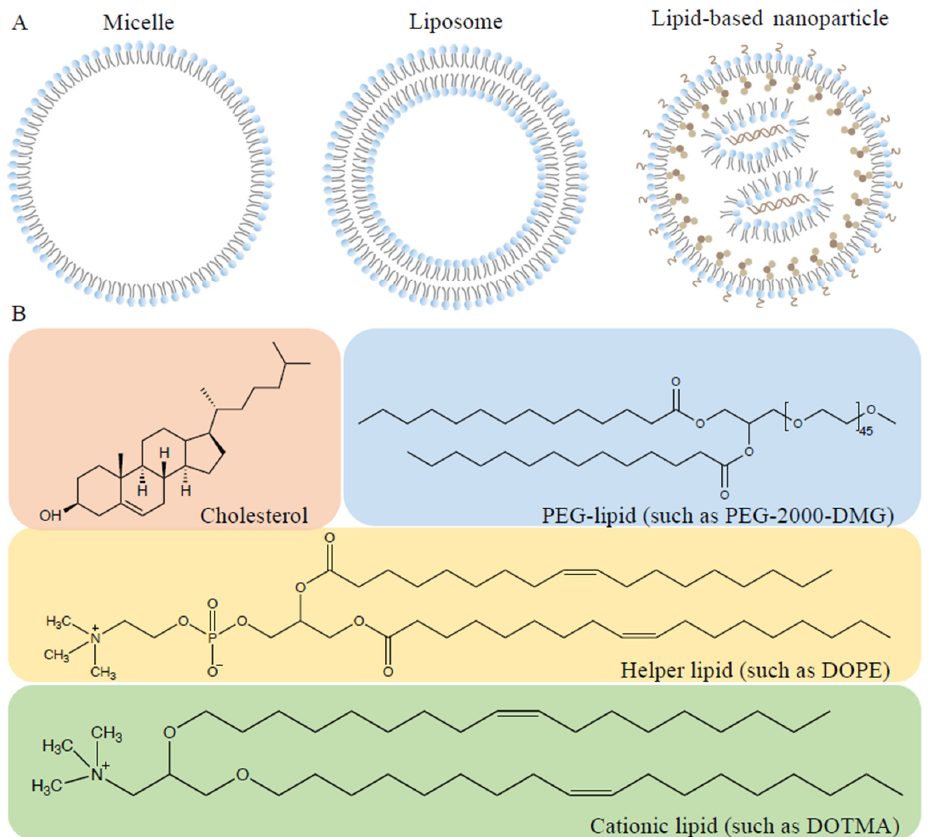
Figure 3. Structures of lipids and lipid-based nanoparticles. ( A ). Lipoplexes include the micelle, which is a single-layer structure, the liposome, which consists of two lipid layers, and the lipid-based nanoparticle. ( B ). The representative components of the Lipid-based nanoparticle. Four chemical structures constitute lipid-based nanoparticles, including cholesterol, PEG-lipids, helper lipids, and cationic or ionizable lipids that are particularly related to the efficiency of LNPs.